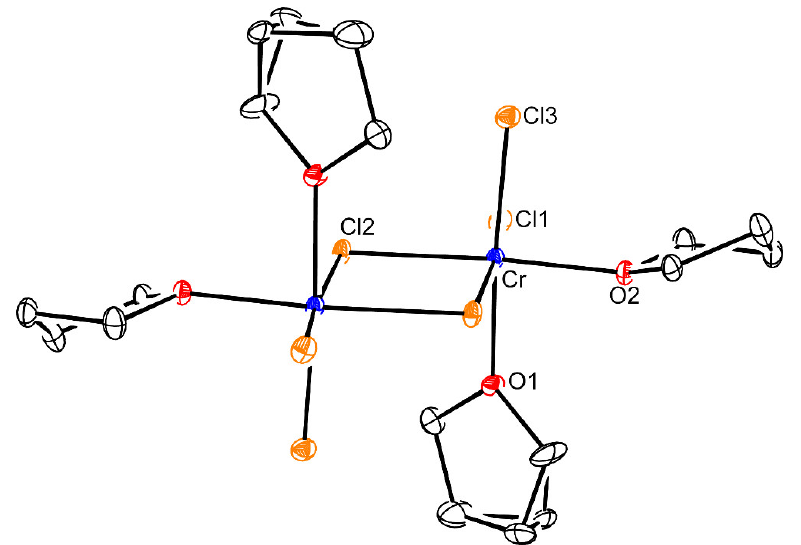
Figure 2. X-ray structure of [CrCl 2 (μ-Cl)(thf) 2 ] 2 . Selected bond distances (Å) and angles (°): Cr-Cl1, 2.2773(12); Cr-Cl2, 2.3622(12); Cr-Cl3, 2.2885(11); Cr-O1, 2.045(3); Cr-O2, 2.018(3); C-O1-C, 109.5(3); C-O1-Cr, 125.5(2); C-O1-Cr, 125.0(2); C-O2-C, 108.7(3); C-O2-Cr, 121.5(2); and C-O2-Cr, 122.6(2).